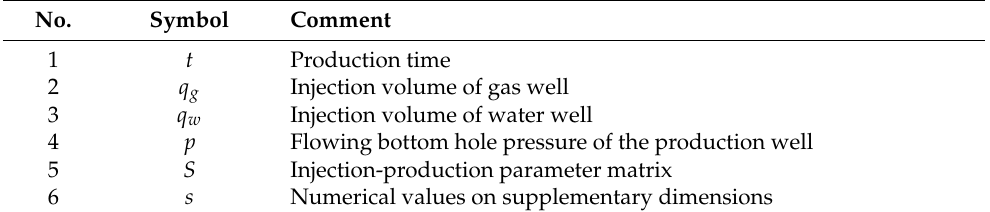
Table 1. Parameter declaration